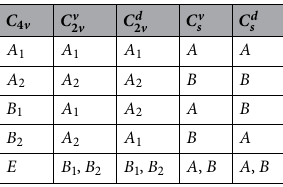
Table 3. Symmetry degeneration table of group C 4 v 36 .